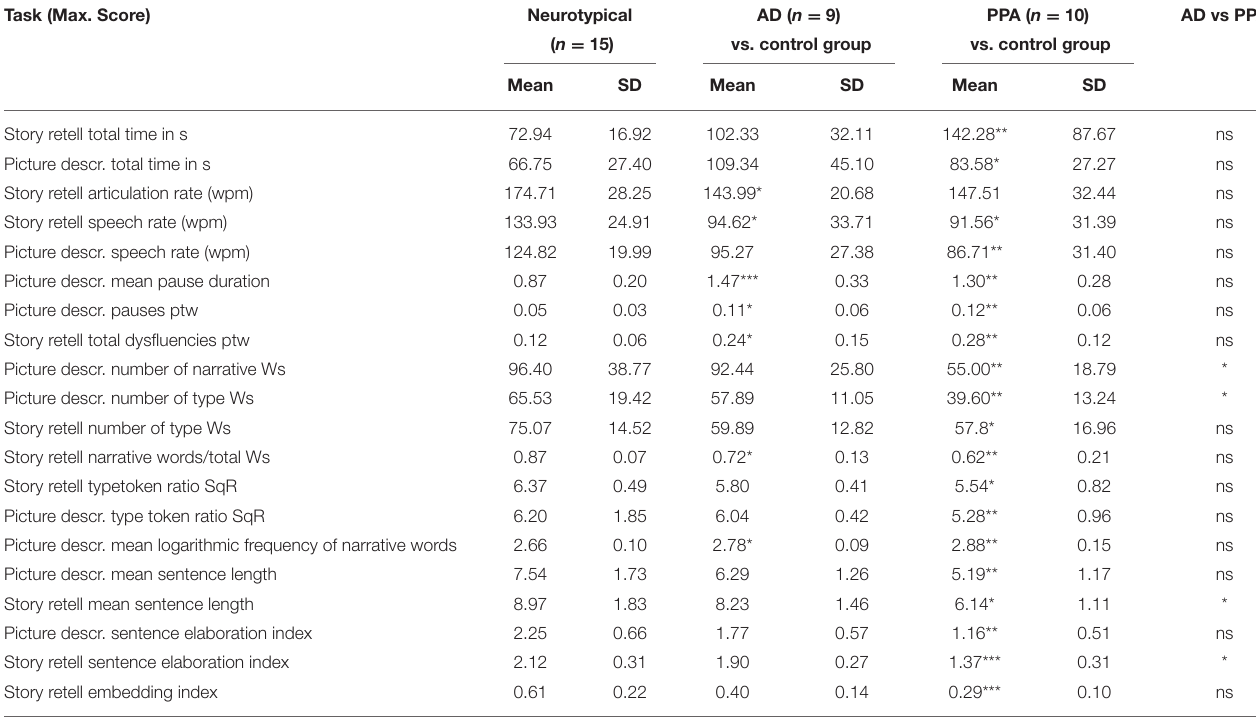
TABLE 4 | Statistically significant results for narrative measures. Task (Max.